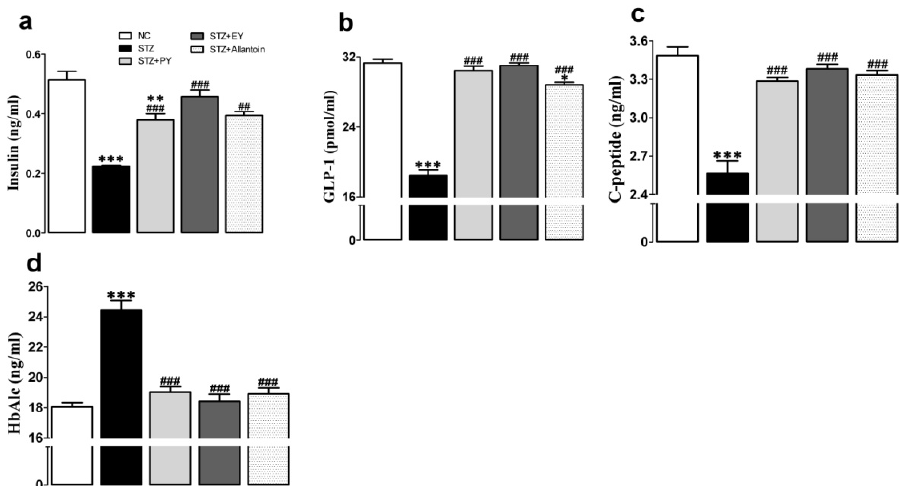
Figure 2. Effects of PY, EY, and allantoin treatments on the serum levels of insulin (a), GLP ‐ 1 (b), C ‐ peptide (c), and HbAlc (d) in STZ ‐ induced diabetic rats: GLP ‐ 1, glucagon ‐ like peptide ‐ 1; HbA1c, glycated hemoglobin. Data are reported as means ± SEMs ( n = 10). *: p < 0.05; **: p < 0.01; and ***: p < 0.001, Bonferroni post hoc test following one ‐ way ANOVA versus the NC group (Cont); # : p < 0.05; ## : p < 0.01; and ### : p < 0.001, Bonferroni post hoc test following one ‐ way ANOVA versus the diabetic control group (STZ).